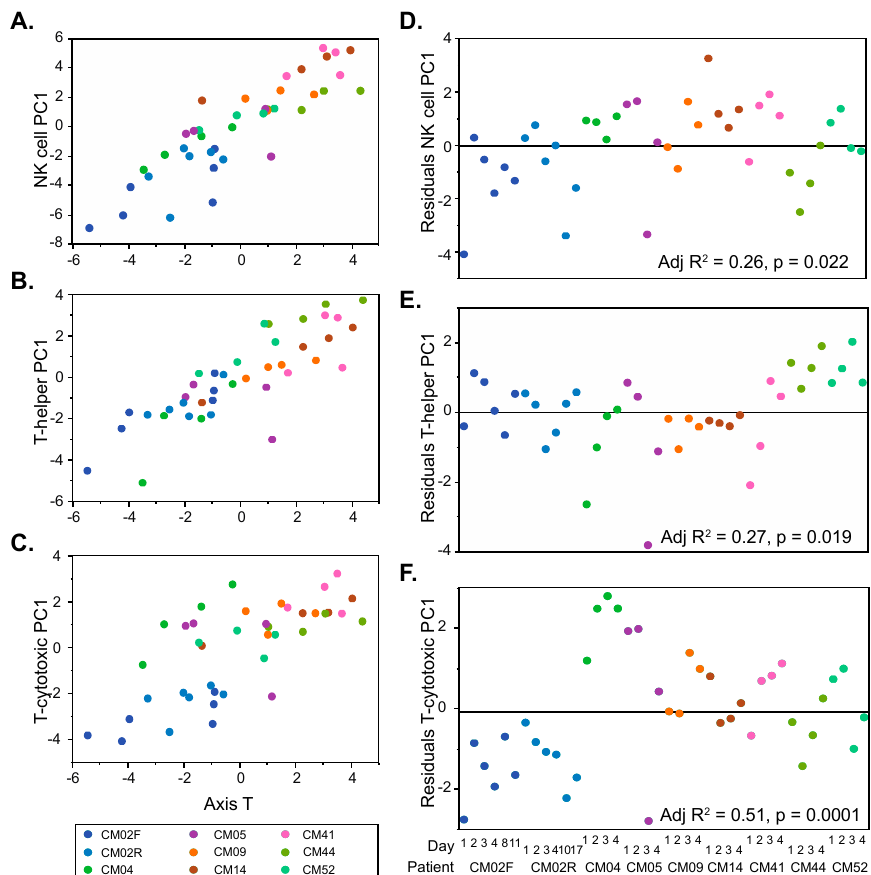
Figure 2. Lymphocyte activity inference in each individual. Each plot ( A – C ) shows how a PC1 based on natural killer (NK) cell, T-helper cell, or T-cytotoxic cell specific transcripts correlates with Axis T and varies by individual, indicated by different colors. Graphs ( D – F ) plot the residuals of the linear regressions by individual, highlighting patient-specific lymphocyte activity. p -values and adjusted R 2 estimates were calculated through an analysis of variance (ANOVA).